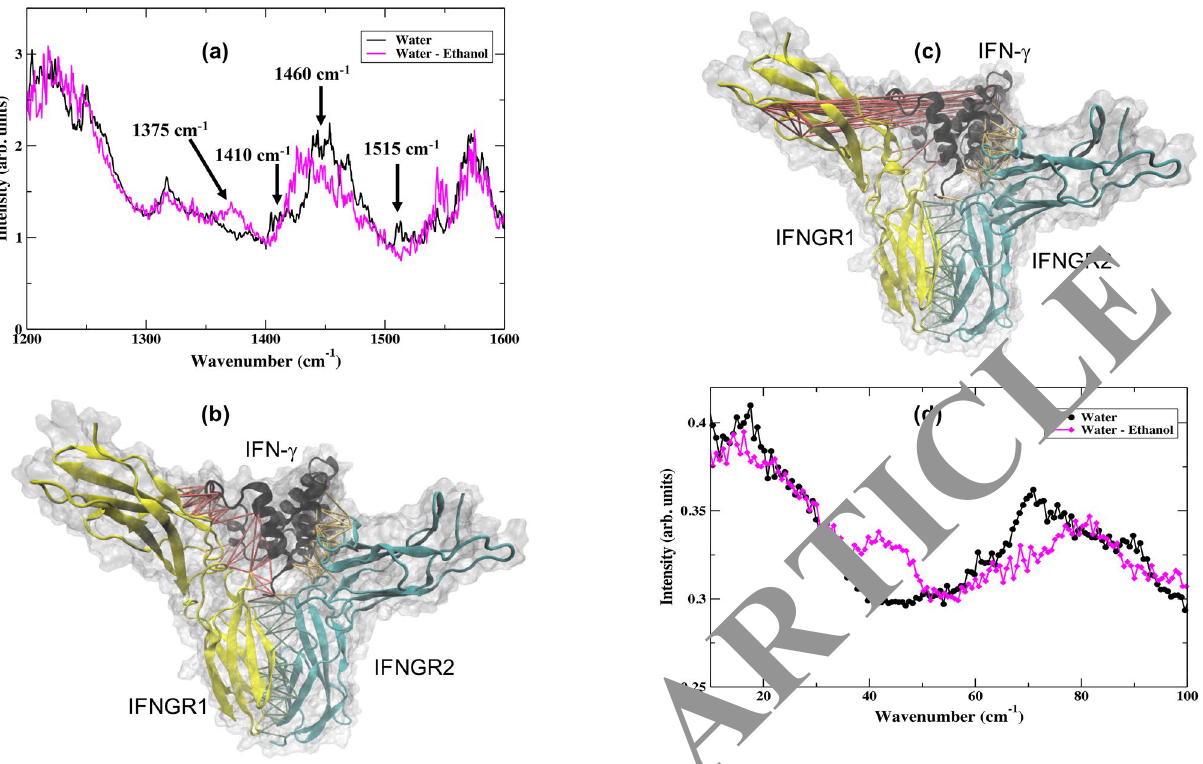
Figure 12. ( a ) The calculated protein-water H-bonding spectrum of the IFN - γ complex from the MD simulation in water (black line) and in the water–ethanol solvent (pink line). The 3-D representation of the IFN - γ complex in ( b ) water and ( c ) in the water–ethanol solvent where the strain propagation from the force distribution analysis (FDA) is represented as colored links. The force between IFN - γ and IFNGR1 is depicted by red links, the force between IFN - γ and IFNGR2 by orange links, and the force between IFNGR1 and IFNGR2 is represented by green links in the 3-D structure. ( d ) The low-frequency vibrational spectrum of the displacement of the correlated cluster of amino acids identified from the FDA of the complex in water (black line with black circles) and in the ethanol–water mixed solvent (pink line with pink